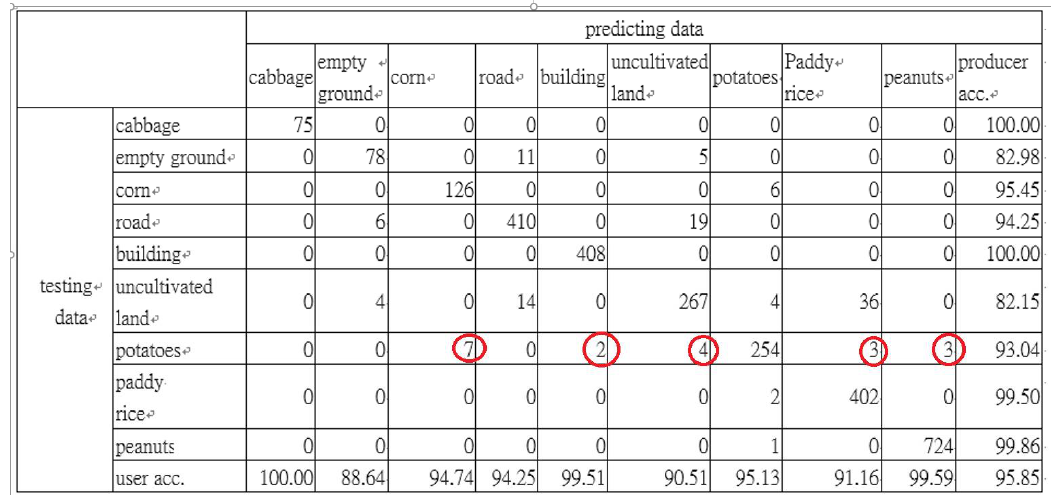
Figure 5. Thematic map of the first stage on SVM. 4.2. Second Stage: Improvement Classification of CNN The study provides nine categories divided into nine classes for the analyzed data of the CNN. Various cell sizes were generated to fit the crop size considering the inputs for CNN. Thus, the regional object classification (ROC) model [32,33] promotes the image information from the pixel-scale to the regional-scale (blocks or cells) by operating units to establish crop information. The information scale from pixel to a regional area needs a program to be written to display the needs of each crop area and was also identified for different crop analyses. As part of this study, the study employed PCA as a feature extraction tool [33,34] for the different components to approach accuracy. A fundamental question arises: